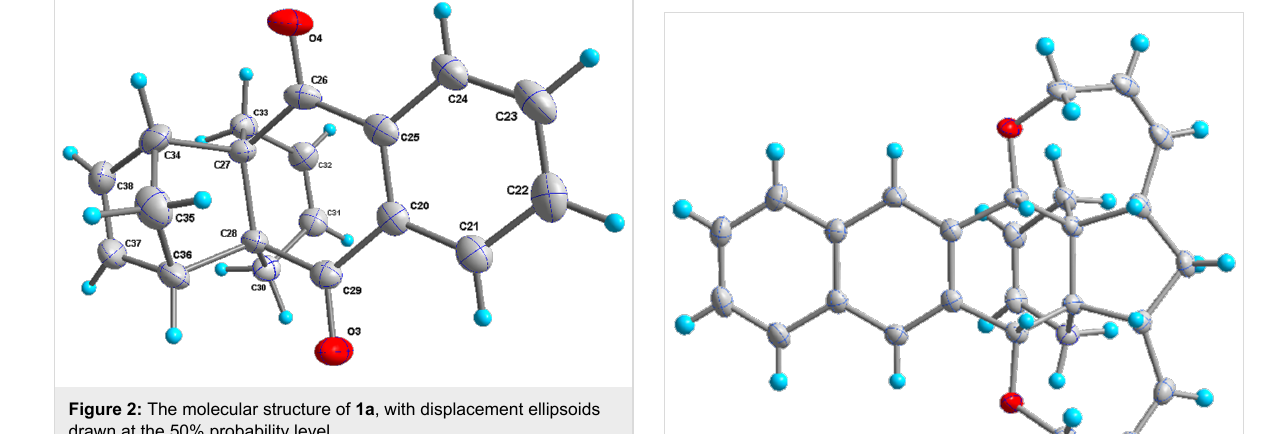
sequence will occupy the exo position (see 2ab ) because the bridgehead hydrogens in DA adduct 3a are in exo configuration. Thus, in the final compound 1a the newly formed 6-membered ring during RCM is supposed to be in the exo configuration.